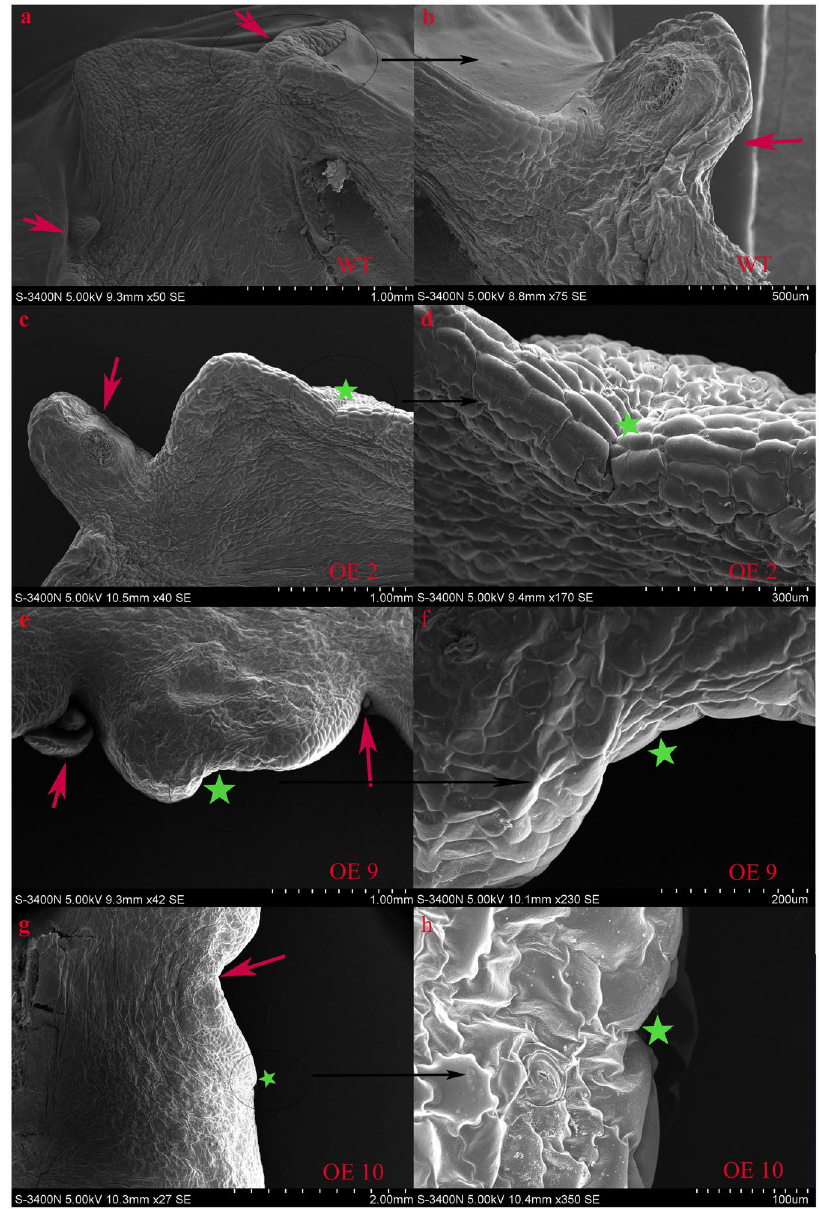
Figure 5. Asymmetric plantlet distribution was formed along the leaf margin of Kalanchoe daigremontiana by SEM scanning. ( a,b ) Normal zygomorphous distribution of plantlet was along WT leaf margin. ( c,e,g ) Asymmetric plantlet distribution was formed along KdSOC1 gene OE plant leave. ( d,f,h ) Plantlet formation pedestal site was disappeared beside leaf margin. Dark pink arrow indicates normal zygomorphous or non- isometric plantlet formation site. Green pentagram indicated absence of pedestal site for plantlet